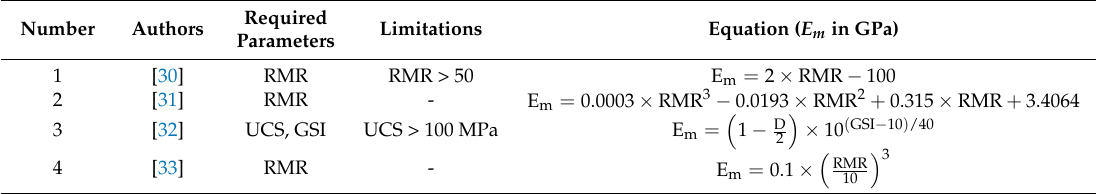
Table 3. Empirical expressions used to obtain E m and the corresponding